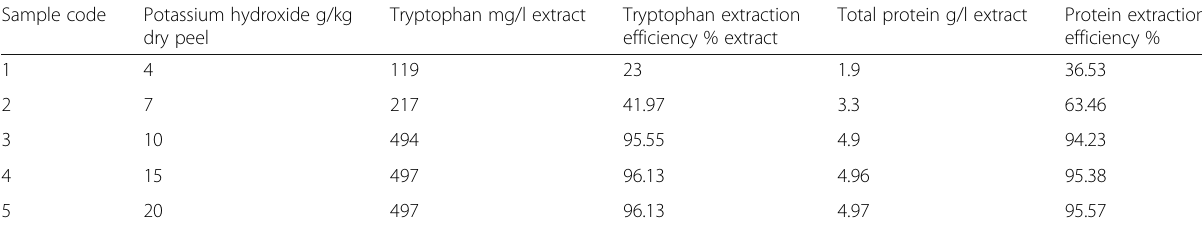
Table 1 Effect of potassium hydroxide dose on tryptophan and total protein extraction Sample code